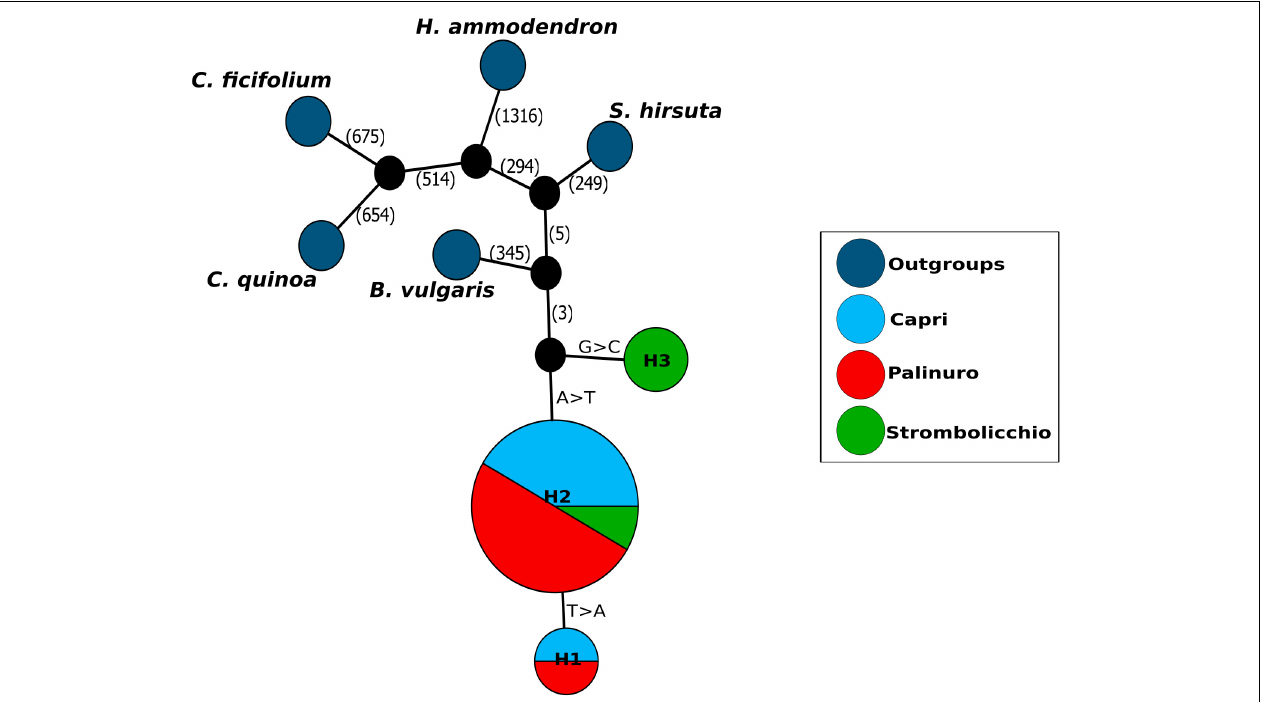
FIGURE 1 | Plastid haplotype network. Each circle represents a different haplotype, where circle size is proportional to the number of individuals that carry the same haplotype. Black circles indicate missing intermediate haplotypes. Mutational steps are reported on the lines of the haplotype networks. Colors show the genotypes belonging to different geographic